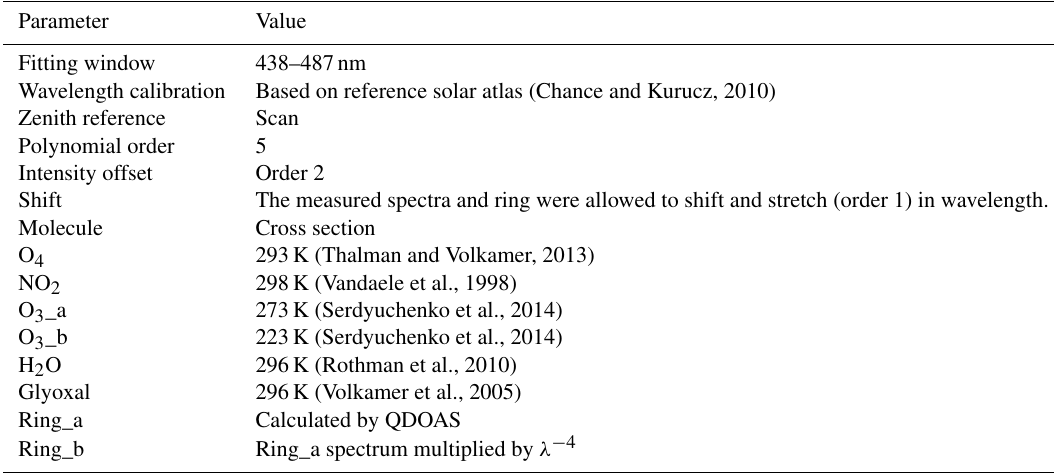
Table 1. DOAS spectral settings for the retrieval of O 4 and NO 2 in the UV. Parameter Value Fitting window 352–387nm Wavelength calibration Based on reference solar atlas (Chance and Kurucz, 2010) Zenith reference Scan Polynomial order 5 Intensity offset Order 2 Shift The measured spectra and ring were allowed to shift and stretch (order 1) in wavelength. Molecule Cross section O 4 293K (Thalman and Volkamer, 2013) NO 2 298K (Vandaele et al., 1998) O 3 _a 273K (Serdyuchenko et al., 2014) O 3 _b 223K (Serdyuchenko et al., 2014) HCHO 297K (Meller and Moortgat, 2000) HONO 296K (Stutz et al., 2000) Ring_a Calculated by QDOAS Ring_b Ring_a spectrum multiplied by λ − 4